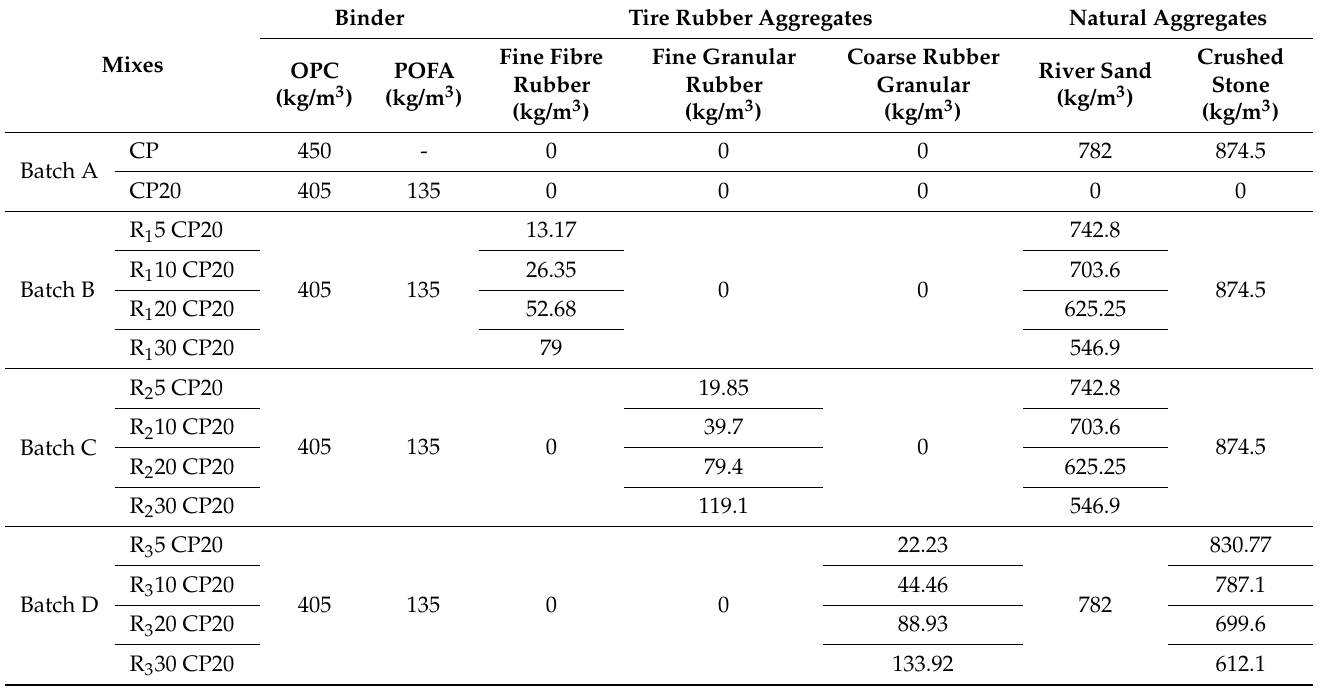
Table 4. Rubberized concrete mix design incorporating tire rubber aggregates with water cement ration 3.8 and superplasticizer